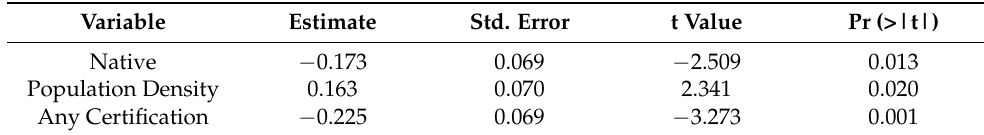
Table 3. Coefficient estimates for scaled Total Performance